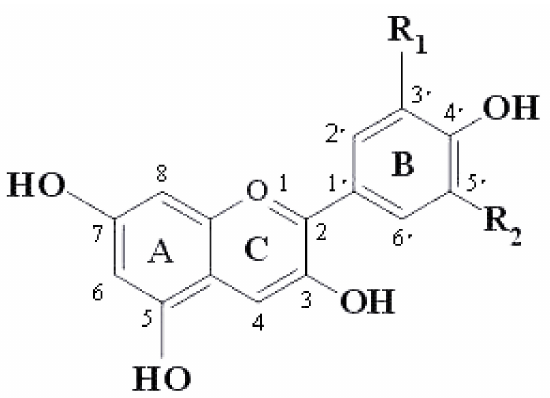
Figure 1. Basic structure of